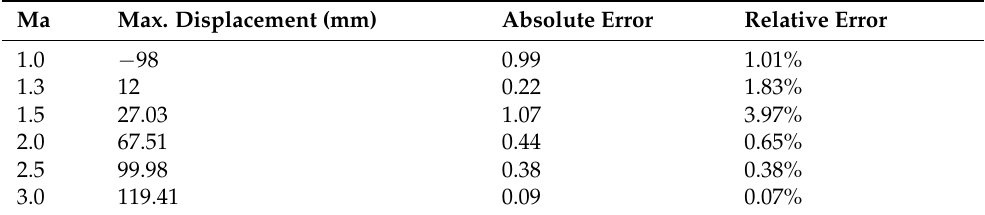
Figure 6. ( a ) Sensor outputs of different Mach numbers of the FFN plate. ( b ) The contrast of the reconstruction results by SMRM with experimental data. ( c ) The deviation of reconstruction results under different Mach numbers. ( d ) The relative error and absolute error of the FFN plate under different Mach number. Table 3. The deformation reconstruction results of FFN plate under different Mach